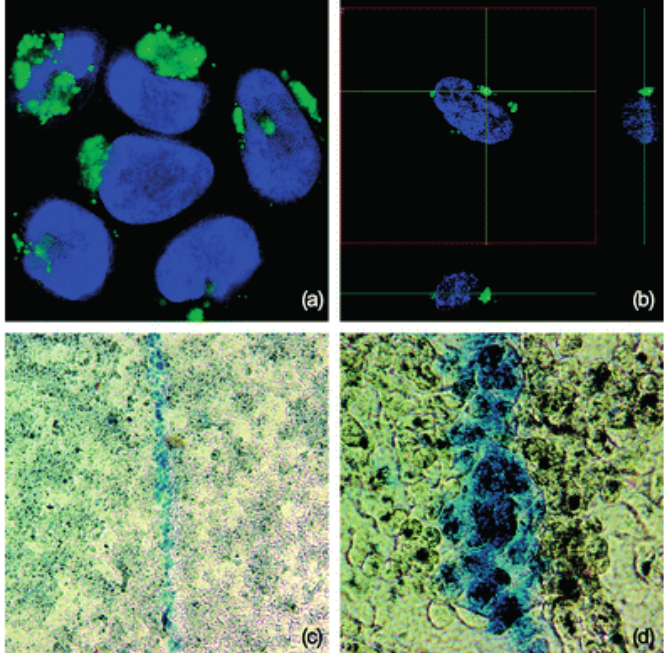
the FITC doped GSS nanoparticles showing the presence of nanoparticles (green) near